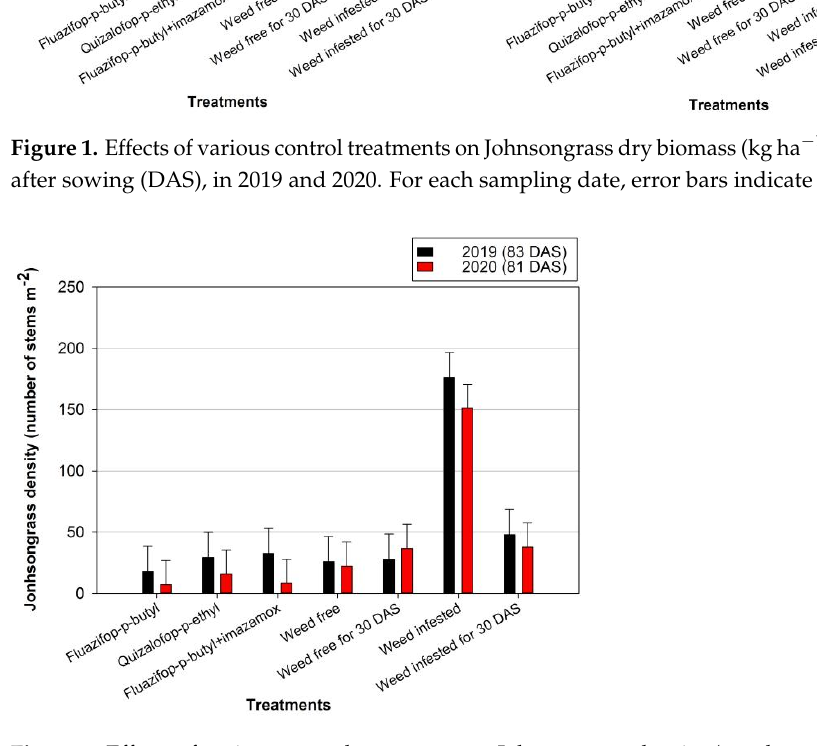
Figure 2. Effects of various control treatments on Johnsongrass density (number of stems m − 2 ) at 81 and 83 days after sowing (DAS), in 2019 and 2020, respectively. For each sampling date, error bars indicate the LSD 5% value.